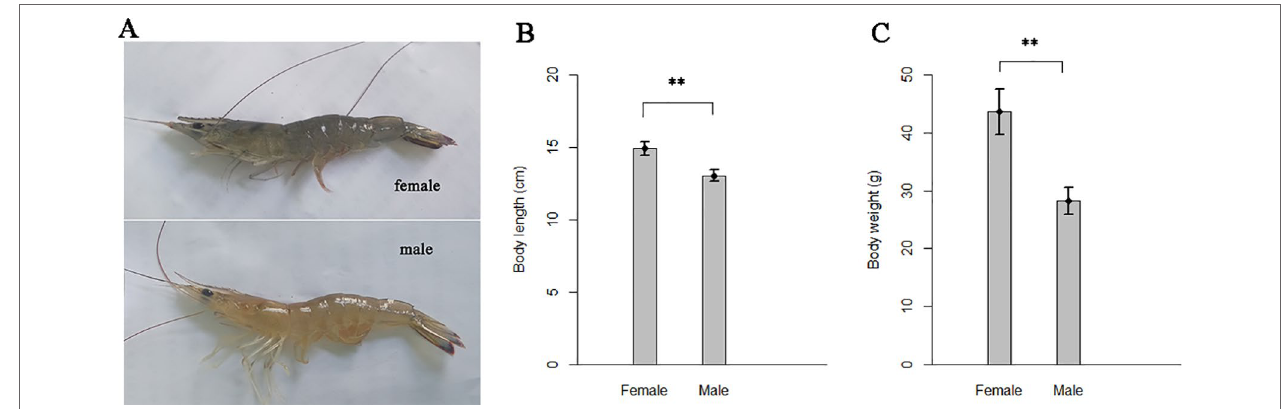
FIGURE 2 | Differences in body color and body size of the two sexes shrimps. (A) Body color. (B) Body length and (C) body weights at 6-months-old. Thirty female and thirty male full-sib shrimps which farmed at a same pond were measured. The line on bar represents standard deviation. “**” indicates significant differences between the two sexes with one-way analysis of variance (P < 0.01).